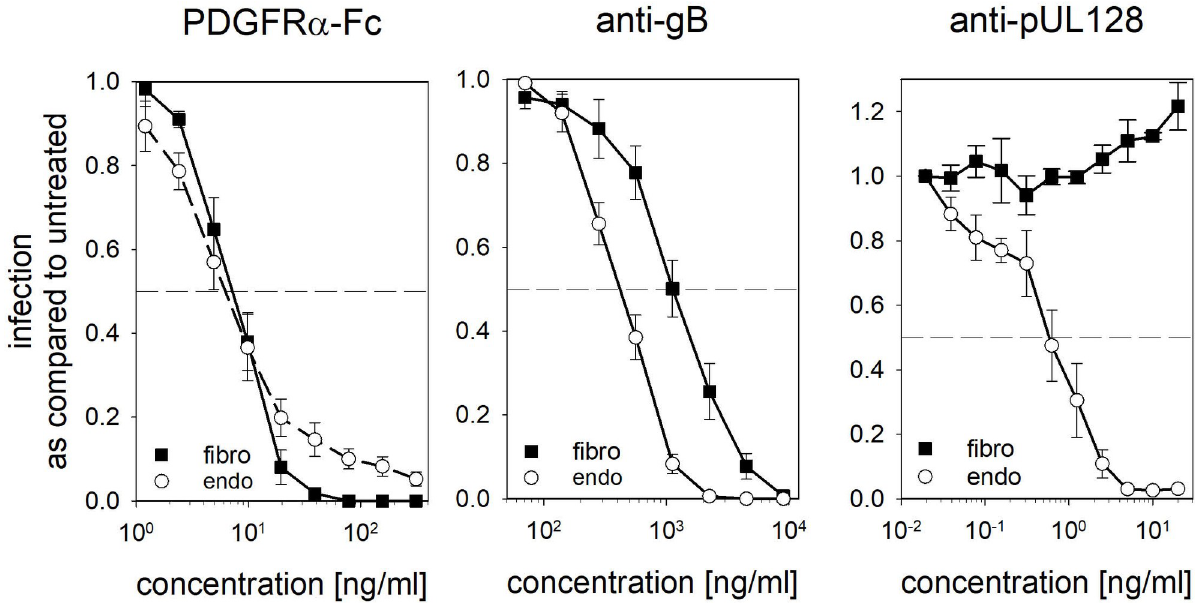
Fig 1. Comparison of the inhibition of fibroblast and endothelial cell infection by PDGFR α -Fc and anti-gB, anti-pUL128 antibodies. Neutralization of TB40-BAC4 infection of fibroblasts (fibro) and endothelial cells (endo) by PDGFR α -Fc, anti-gB clone C23 and anti-pUL128 clone 4I22 was tested. The virus was diluted to an MOI of � 1 and preincubated for 2 h at 37˚C with the indicated concentrations of PDGFR α -Fc or the respective purified monoclonal antibody. The cells were incubated with the virus/inhibitor mixtures for 2 h. After 24h the cells were fixed and stained for the viral immediate early proteins to determine the percentage of infected cells in each condition. Shown is the percentage of infection as compared to an untreated control. The experiments were performed 5 times for PDGFR α -Fc, 7 times for anti-gB and 3 times for anti-pUL128. Error bars indicate standard error of the